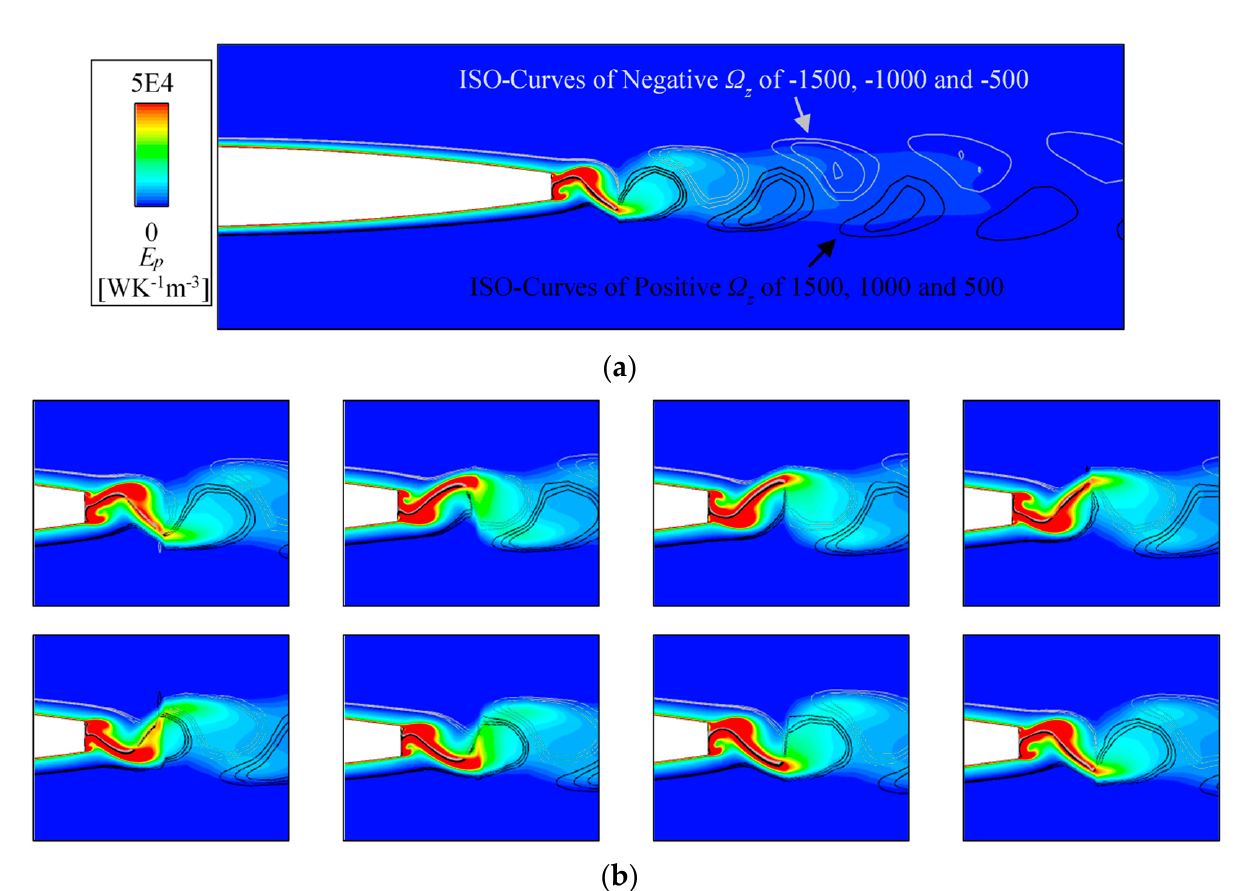
Figure 8. Temporal variation of vortex shedding with interactions. ( a ) Pattern of entropy production and Ω z at a specific time step. ( b ) Pattern of 8 continual time steps with 0.0001 s between every two steps.